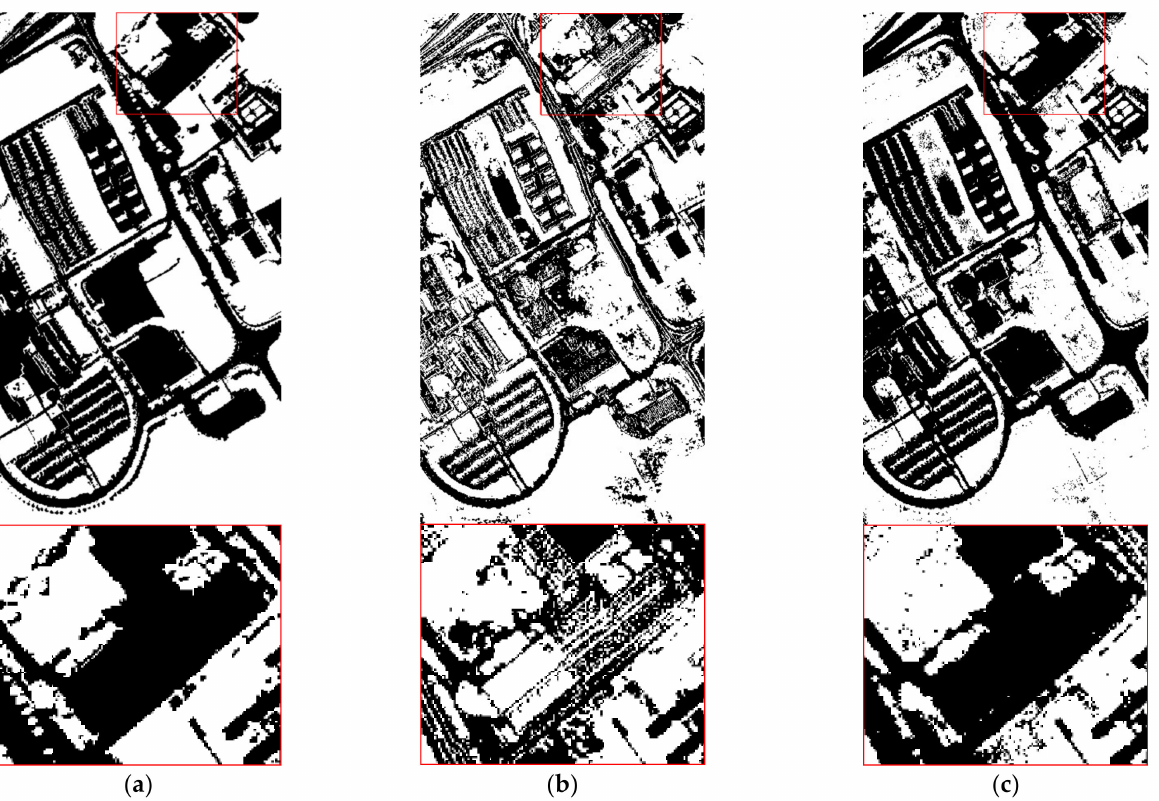
Figure 9. Extraction results of vegetation and partial enlarged image: ( a ) Ground truth information; ( b ) NDVI extraction result; ( c ) BAND19 extraction result.